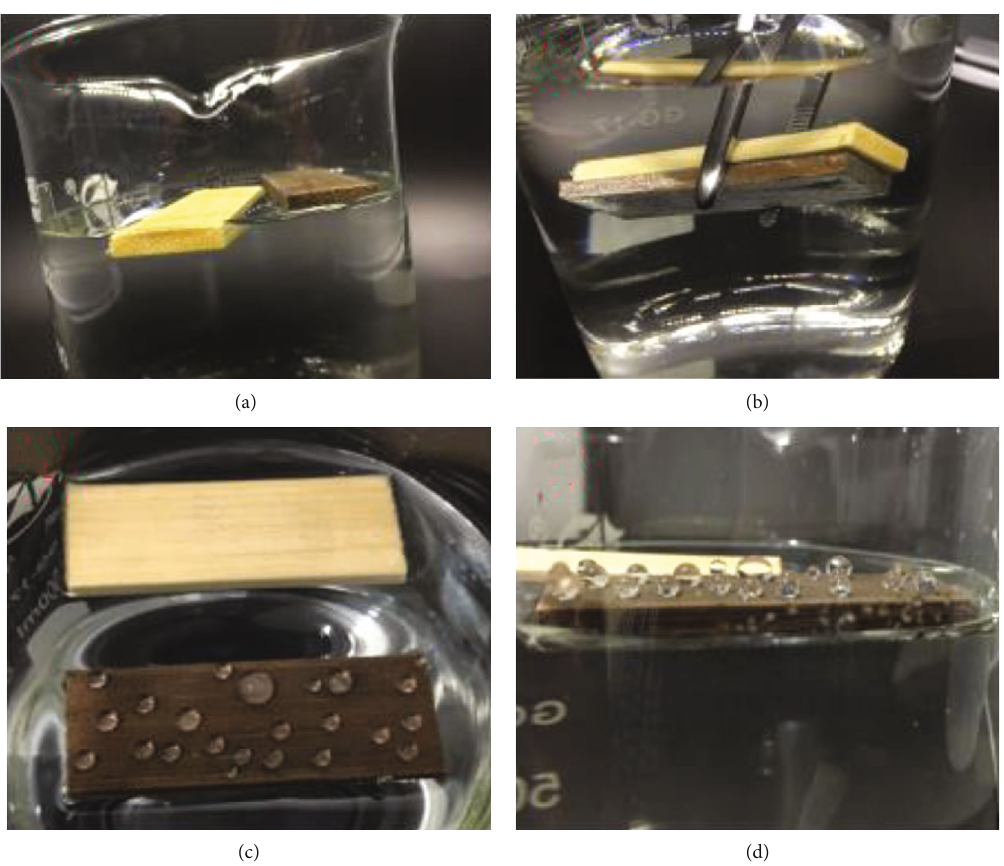
Figure 10: Digital photos of immersion of BT and FAS-RGO@SiO